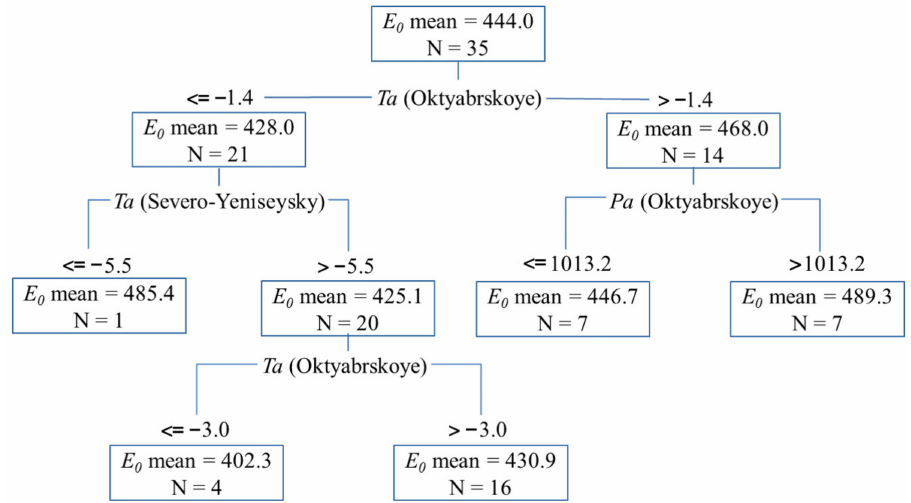
Figure 3. Decision tree for annual values of potential evapotranspiration (mm/year) of the Ob’s basin, consisting of 4 branches for